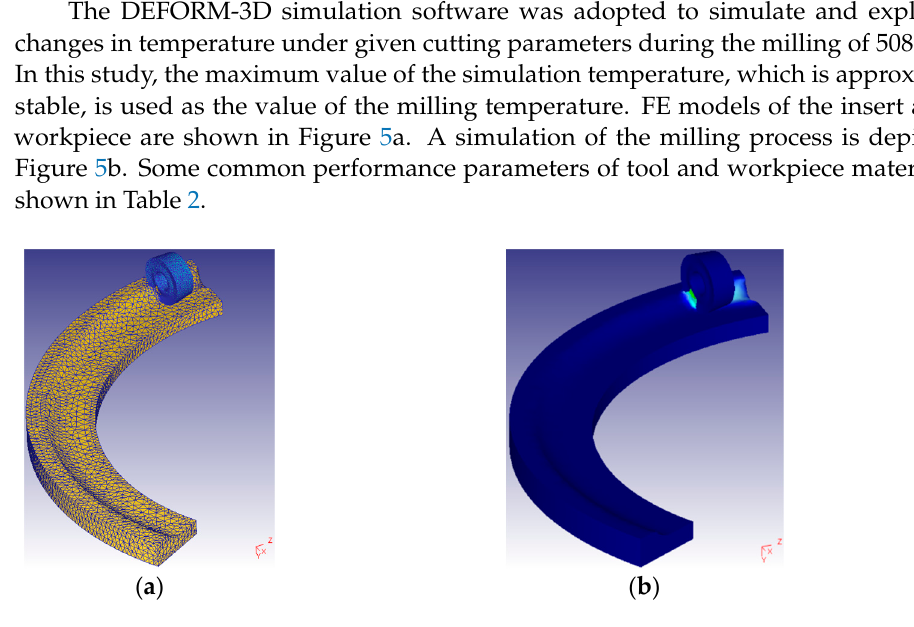
( b ) Figure 4. Semi-arti fi cial thermocouple of 508 III steel-NiCr. ( a ) Indexing thermoelectric characteris- tics, ( b ) Fi tt ing curve. By repeating indexing and calibration experiments, the fi tt ing curve of the 508 III steel-NiCr semi-arti fi cial thermocouple obtained is shown in Figure 4b. The fi tt ing equa- tion of the 508 III steel-NiCr semi-arti fi cial thermocouple is shown in Equation (4). From Figure 4b, it can be found that the sampling points are basically evenly distributed on both